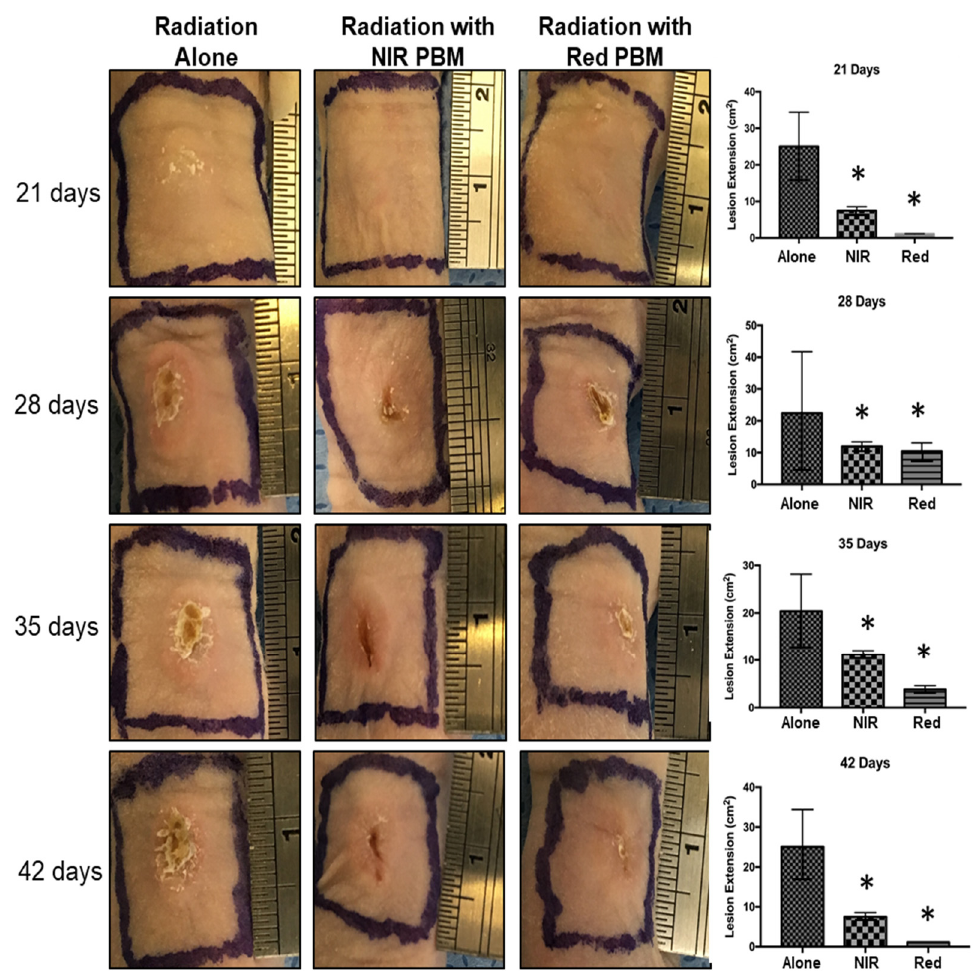
Figure 2. Wound images from representative animal groups over time after 125 I brachytherapy and PBM treatments at 21, 28, 35, and 42 days Digital quantitation of lesions is shown on the right panel as means with standard deviation; * denotes statistical significance n = 6, p < 0.05 with Kruskal–Wallis and Dunn’s test.